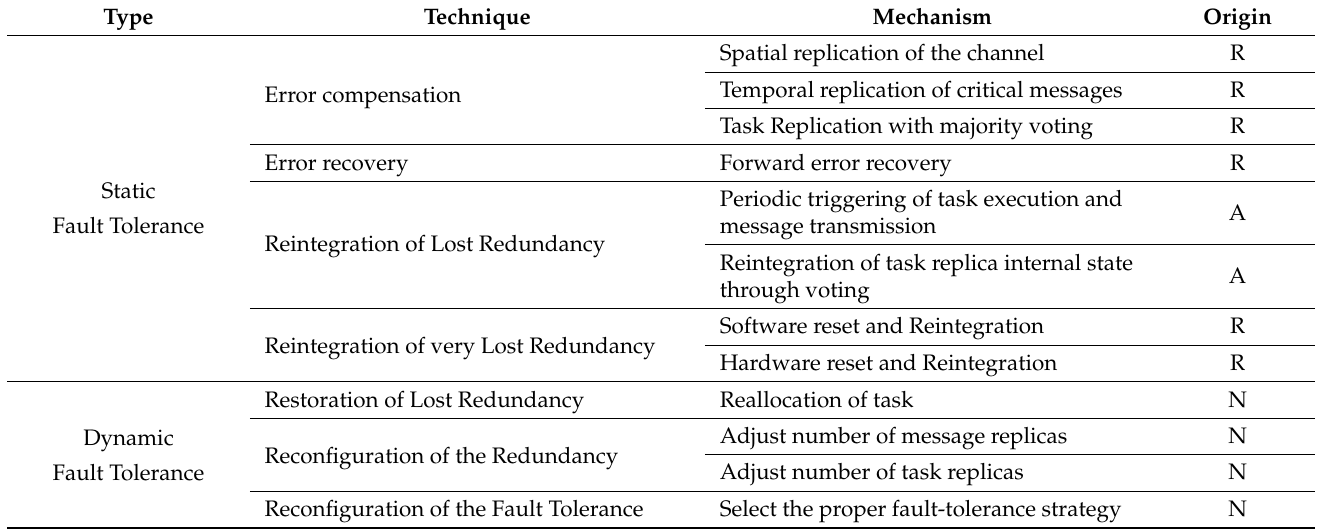
Table 1. Taxonomy of the DFT4FTT fault-tolerance